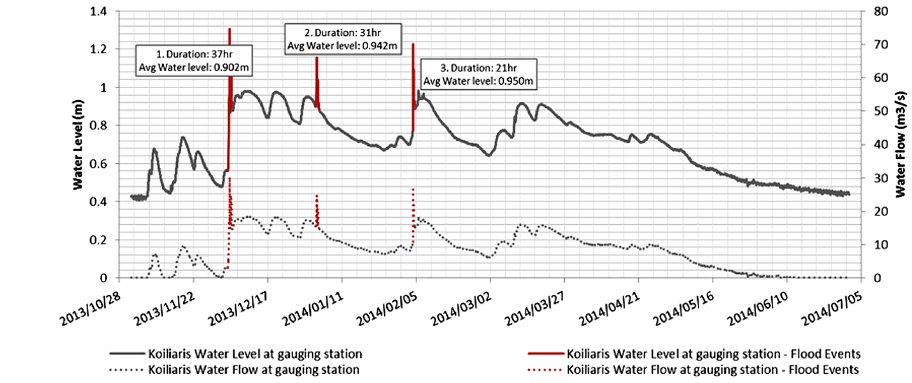
Figure 2. Typical hydrograph of the Koiliaris River at the gauging station (November 2013–June